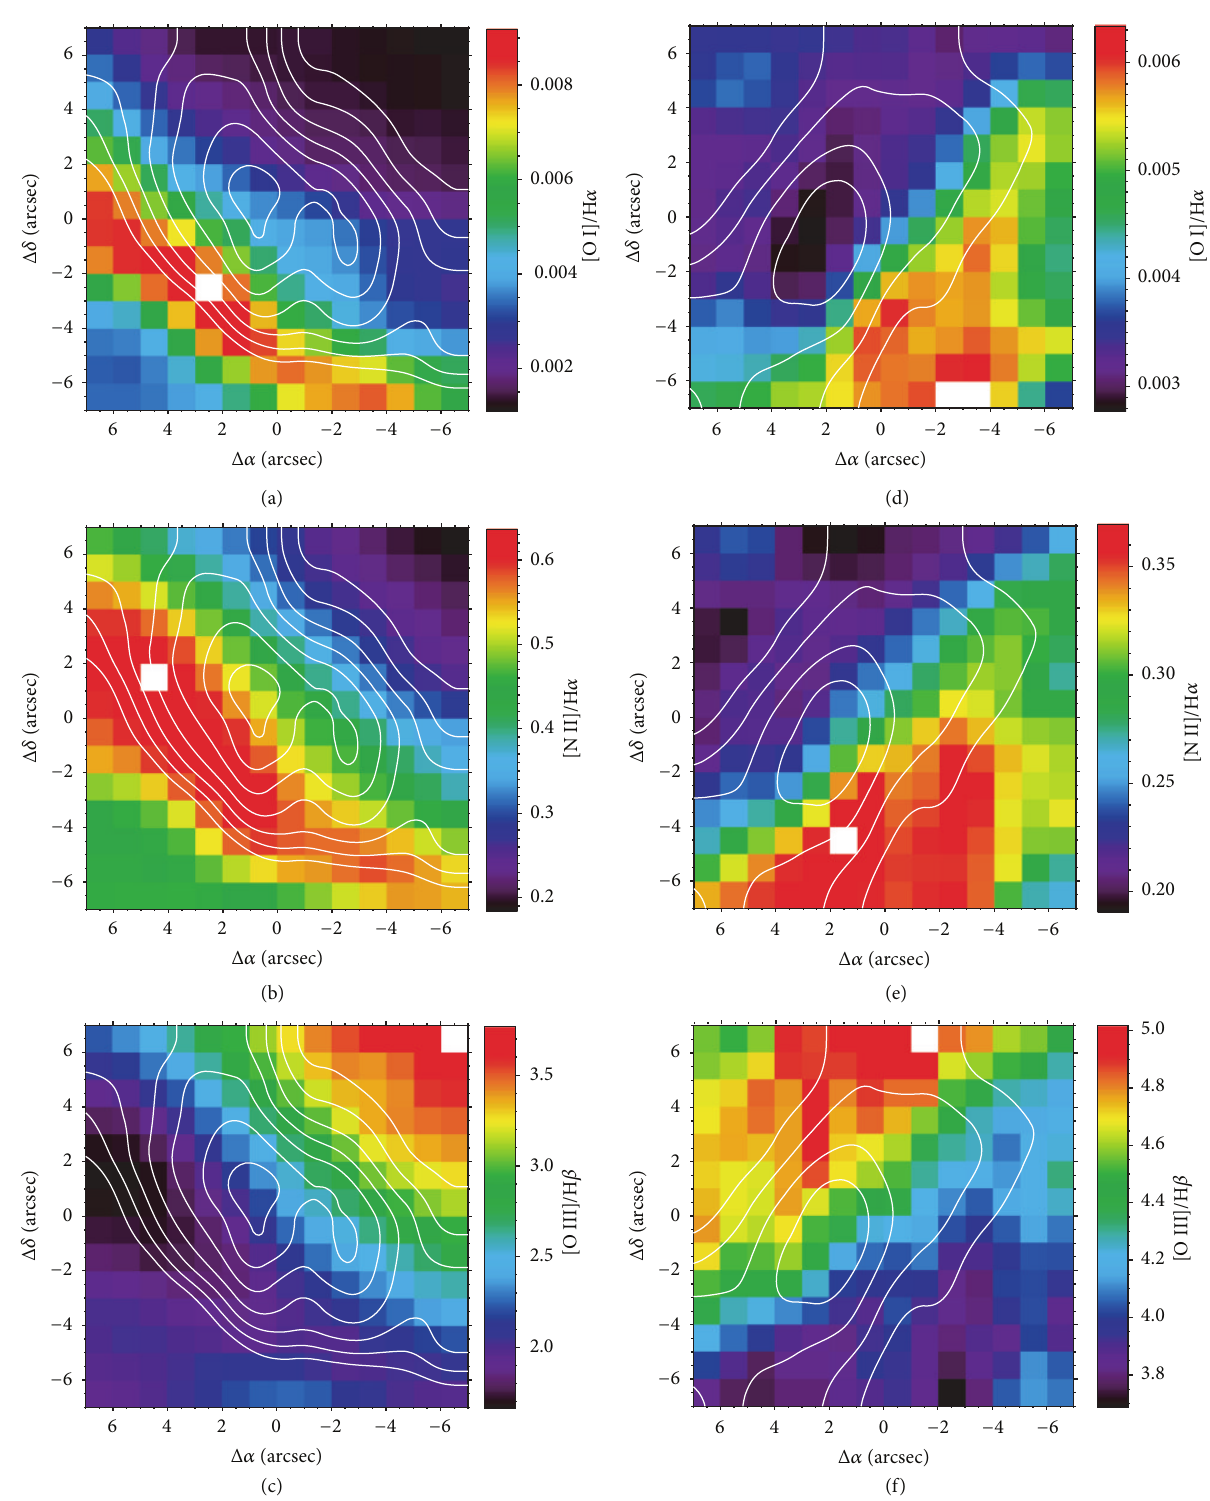
Figure 2: Spatial distribution maps of selected emission line ratios for the Bright Bar (left-hand side) and NE-Orion-S (right-hand side) taken from [37]. The sum of [N II] 6548, 6584 ˚A and [O III] 4959, 5007 ˚A nebular lines have been used to derive the [N II]/H 𝛼 (middle) and [O III]/H 𝛽 (bottom) ratios, respectively. H 𝛼 contours are overplotted in all